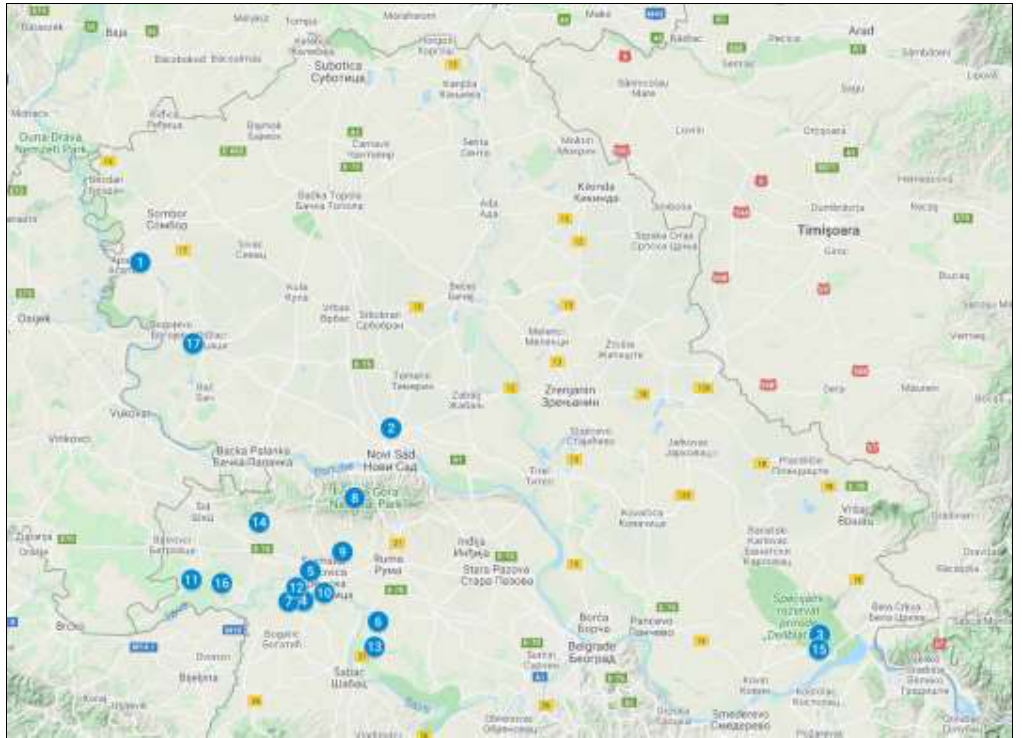
Figure 1. Map showing the study localities in the Vojvodina Province (1 − Banja Junaković, 2 − Rimski Šančevi, 3 − Dubovac, 4 − Noćaj, 5 − Laćarak, 6 − Hrtkovci, 7 − Radenković, 8 − Fruška Gora, 9 − Veliki Radinci, 10 − Salaš Noćajski, 11 − Morović, 12 − Zasavica, 13 − Platičevo, 14 − Erdevik, 15 − Šumarak, 16 − Višnjićevo, 17 −